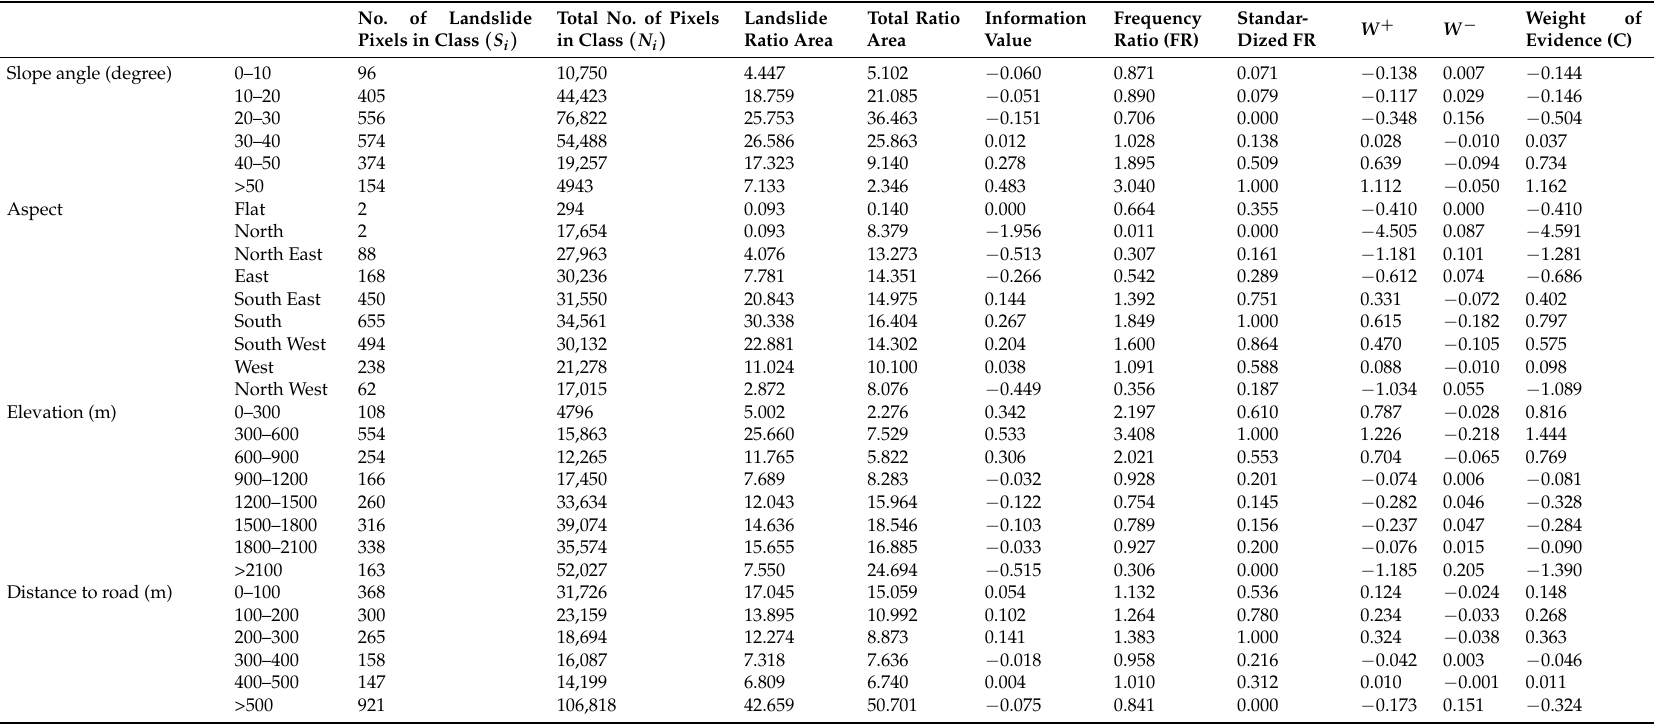
Table A1. Information value, weight of evidence, and logistic regression indices for landslide causal